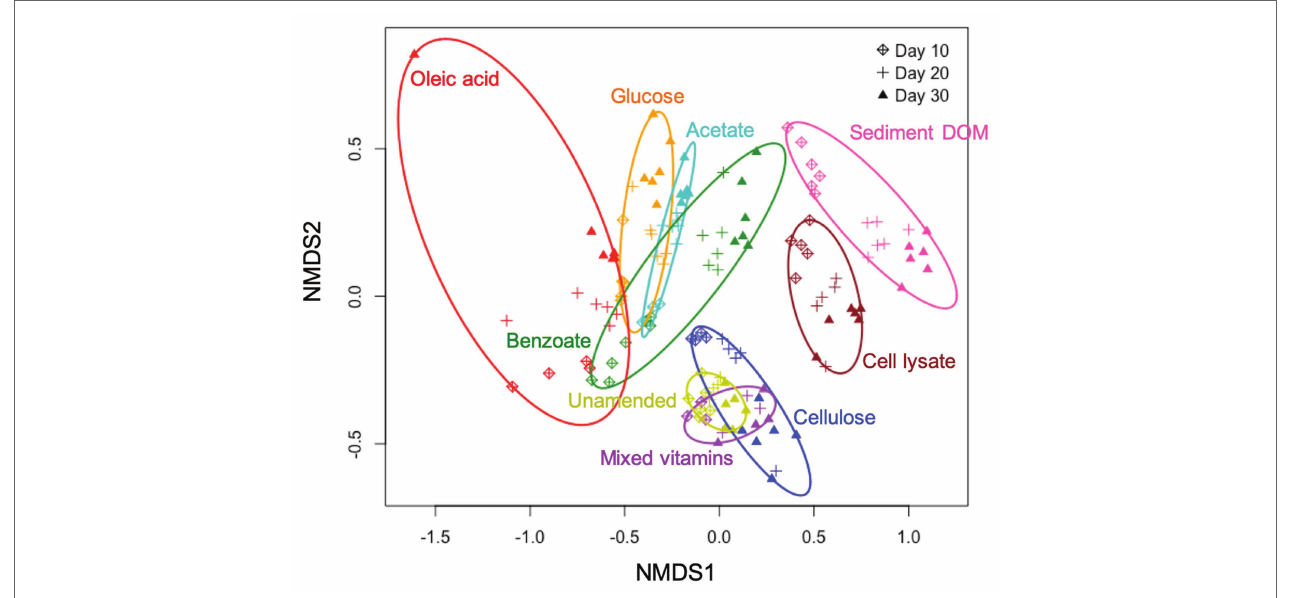
FIGURE 1 | Non-metric multidimensional scaling (NMDS) plot based on Bray-Curtis dissimilarities of bacterial community composition in different C-amended